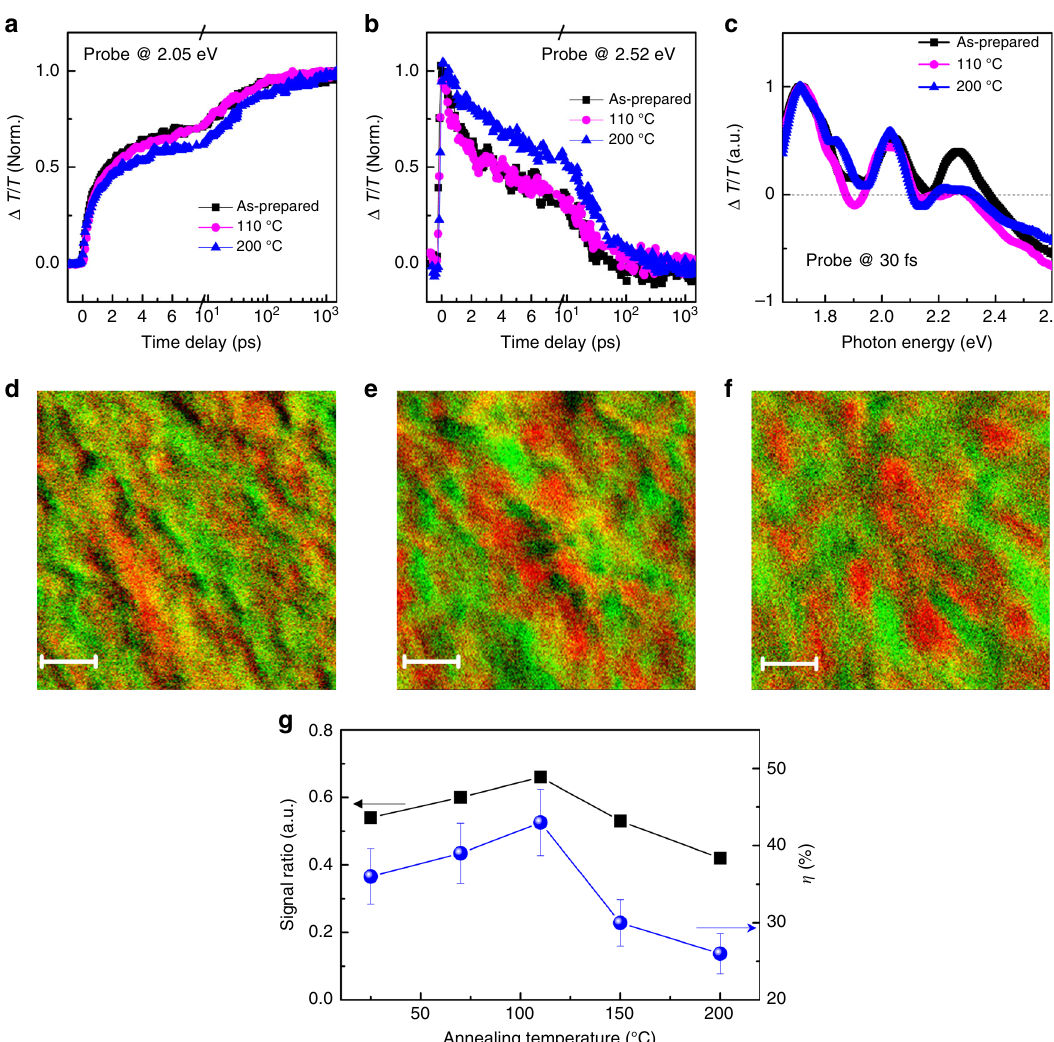
Fig. 5 Morphology effect on iPP-mediated hole transfer. TA traces probed at a 2.05 eV and b 2.52 eV recorded from the blend samples before (as- prepared) and after annealing at 110 and 200 °C, respectively. c TA spectra recorded at a time delay of 30 fs recorded from the blend samples annealed at different temperatures. The spectra are normalized at to the signal probed at 1.75 eV (Fig. 5c) to compare the relative signal amplitudes of iPPs in different blends. The photon energy of the pump beam is 1.75 eV. PiFM images show the morphologies of the blend samples d before (as-prepared) and after annealing at e 110 °C and f 200 °C, respectively. The characteristic FTIR wavelengths corresponding to the polymer donor (1061 cm − 1 , green) and the polymer acceptor (1712 cm − 1 , red) are selected for better contrast of the PiFM images. The scale bar is 50 nm in d , e , and f . g The amplitude ratio between the signals probed at 2.52eV and 1.75 eV probed at the delay of 30 fs and the estimated ef fi ciency of iPP generation ( η ) are plotted versus annealing temperature. Error bars represent standard deviations in the determination of the iPP generation ef fi ciencies obtained by averaging several